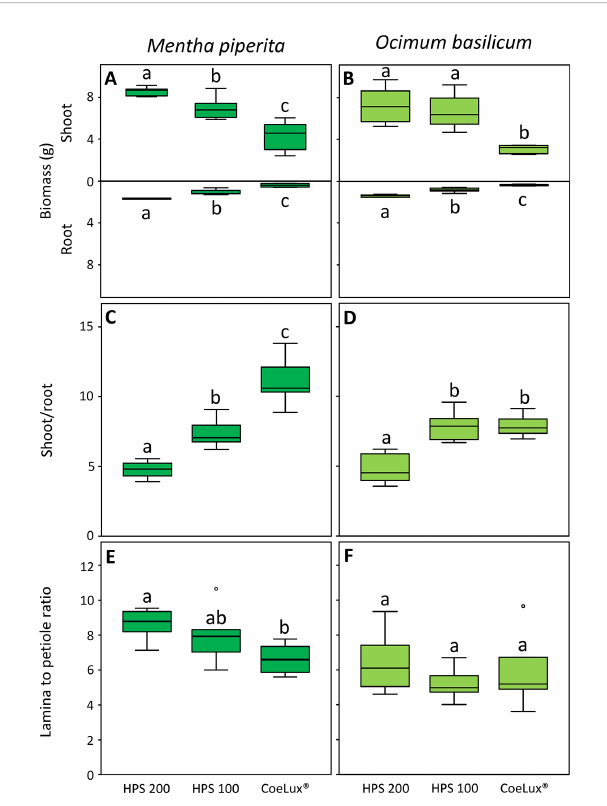
FIGURE 6 (A, B) leaf area (cm 2 ), (C, D) leaf biomass (g), and (E, F) leaf mass per area (g m -2 ) measured under different light treatments for Mentha piperita (dark green) and Ocimum basilicum (light green) plants. Box plots represent n=6 biological repeats while letters represent statistically signi fi cant differences (p< 0.05). Vertical boxes represent approximately 50% of the observations and lines extending from each box are the upper and lower 25% of the distribution. Within each box, the solid horizontal line is the median value. Circles and asterisks represent respectively outliers and extreme outliers.